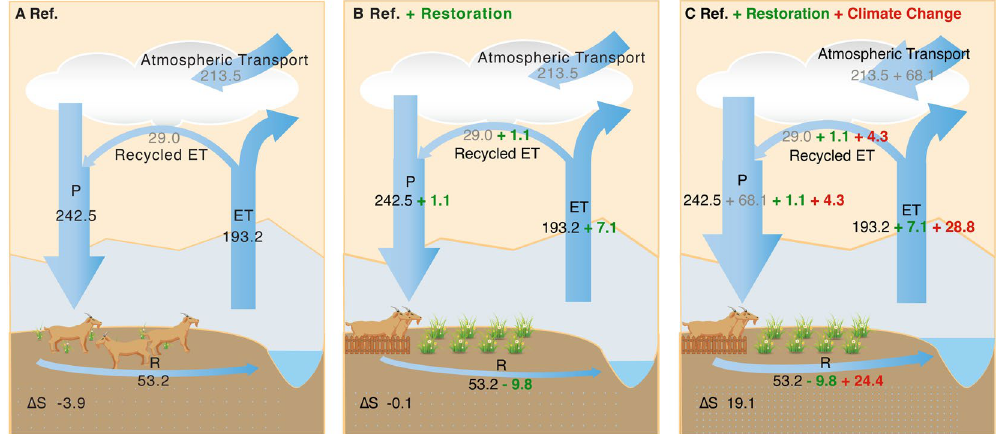
Figure 3. Changes in catchment water balance components in response to grassland restoration and climate change in the headstream region of the Yangtze River. ( A–C ) Represent three different scenarios for water balance components during the growing season (June-September). ( A,C ) Are “true” scenarios that denote the mean state of water balance components during pre-restoration (reference period) and post-restoration period, respectively. ( B ) Represents a pseudo-scenario with restored grassland but no climate change relative to the reference period. Precipitation (P) and evapotranspiration (ET) are derived from MSWEP and GLEAM respectively. R is the observed streamflow from Zhimenda hydrological station situated at the outlet of HYZR. Δ S represents change in root-zone soil water storage that is calculated as the residual based on catchment water balance equation (R = P − ET − Δ S). The numbers in black denote the data taken from either observations or products. The numbers in gray indicate that these values are estimated based upon atmospheric moisture tracking model. The numbers in green and red represent changes in water balance components due to grassland restoration and climate change respectively, and the methods used to estimate these numbers are referenced to the main text (see Data and Methods). Note that Ref. denotes the reference period or the pre-restoration period. This image is generated from Adobe Illustrator CC software.